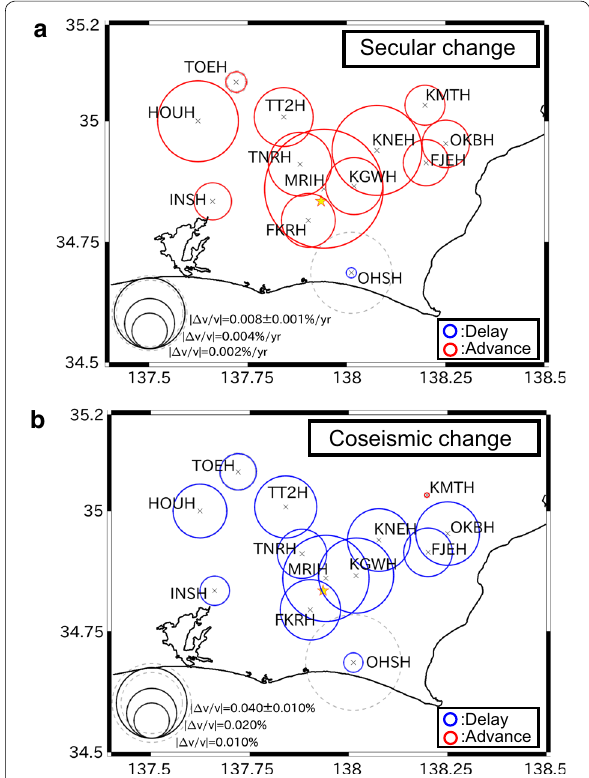
Fig. 4 Estimated secular and coseismic change. Secular change rate ( a ) and coseismic step ( b ) estimated by the model fitting to the daily transfer functions. Blue and red circles indicate delay and advance, respectively. The relative magnitudes of coseismic step and secular change are represented by the area of the solid circles. The dashed circle attached to each solid circle shows the estimation